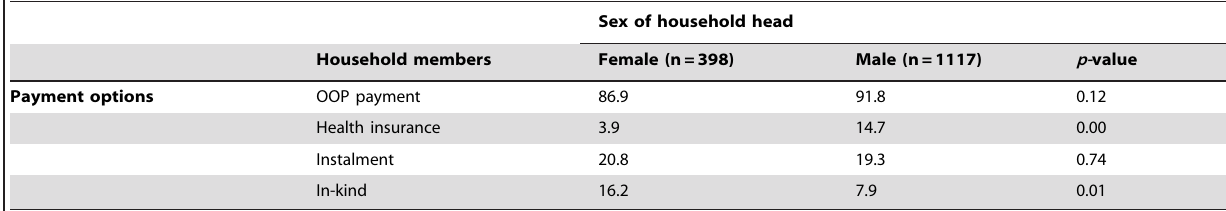
Table 2. Health care payment options.